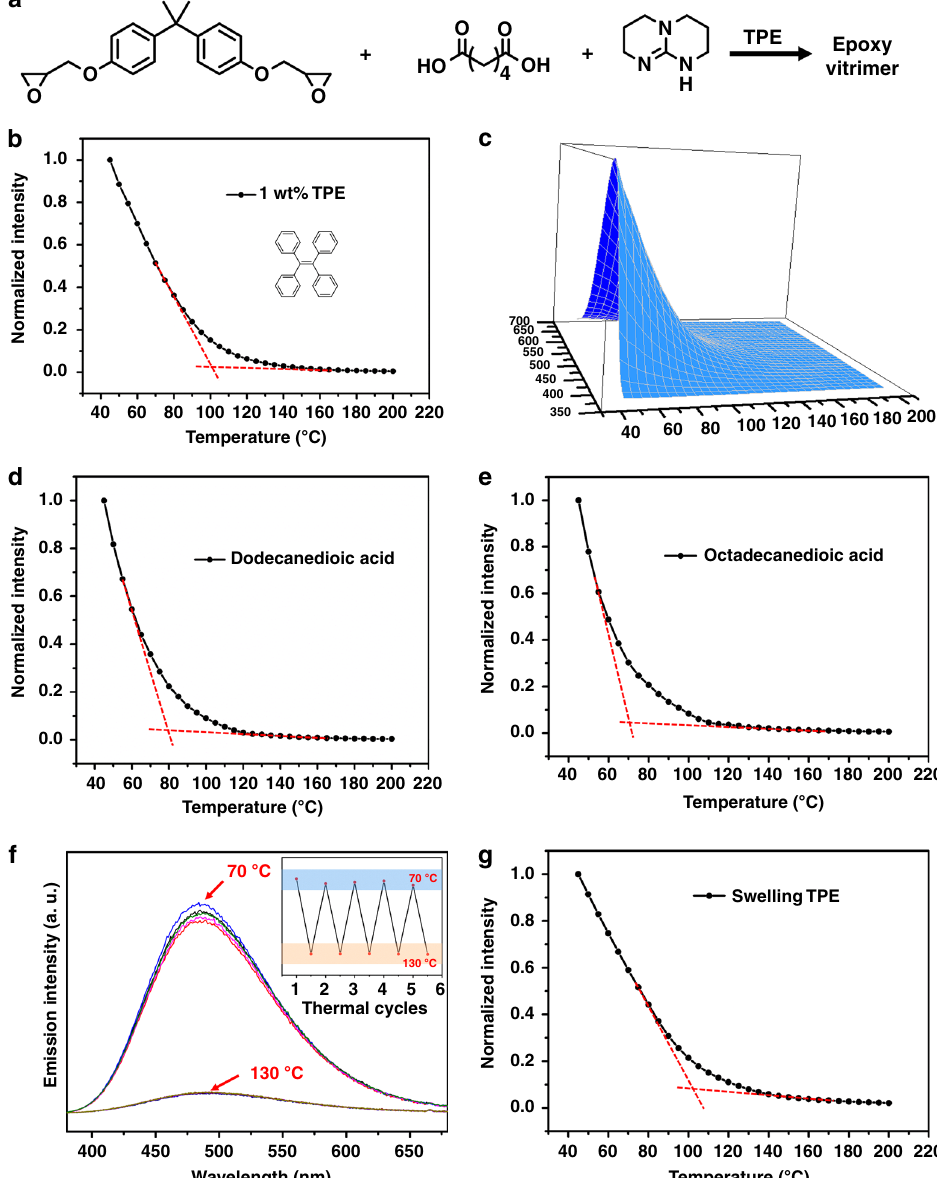
Fig. 2 Fluorescent properties of TPE-doped epoxy vitrimer. a Synthesis of TPE-doped epoxy vitrimer. b The fl uorescence intensity plot of 1 wt% TPE-doped epoxy vitrimer at a series of temperature at 470 nm (Excitation: 365 nm). All the fl uorescence intensities are normalized to 45 °C. c Fluorescence spectra of 1 wt% TPE-doped epoxy vitrimer at a series of rising temperatures. Excitation: 365 nm. d The fl uorescence intensity plot of 1 wt% TPE-doped epoxy vitrimer cured by dodecanedioic acid at a series of temperature at 470 nm (Excitation: 365 nm). All the fl uorescence intensities are normalized to 45 °C. e The fl uorescence intensity plot of 1 wt% TPE-doped epoxy vitrimer cured by octadecanedioic acid at a series of temperature at 470 nm (Excitation: 365 nm). All the fl uorescence intensities are normalized to 45 °C. f Fluorescence spectra of 1 wt% TPE-doped epoxy vitrimer at 70 °C and 130 °C by switching several cycles. Excitation: 365 nm. g The fl uorescence intensity plot of TPE-swelled epoxy vitrimer at a series of temperature at 470 nm (Excitation: 365 nm). All the fl uorescence intensities are normalized to 45